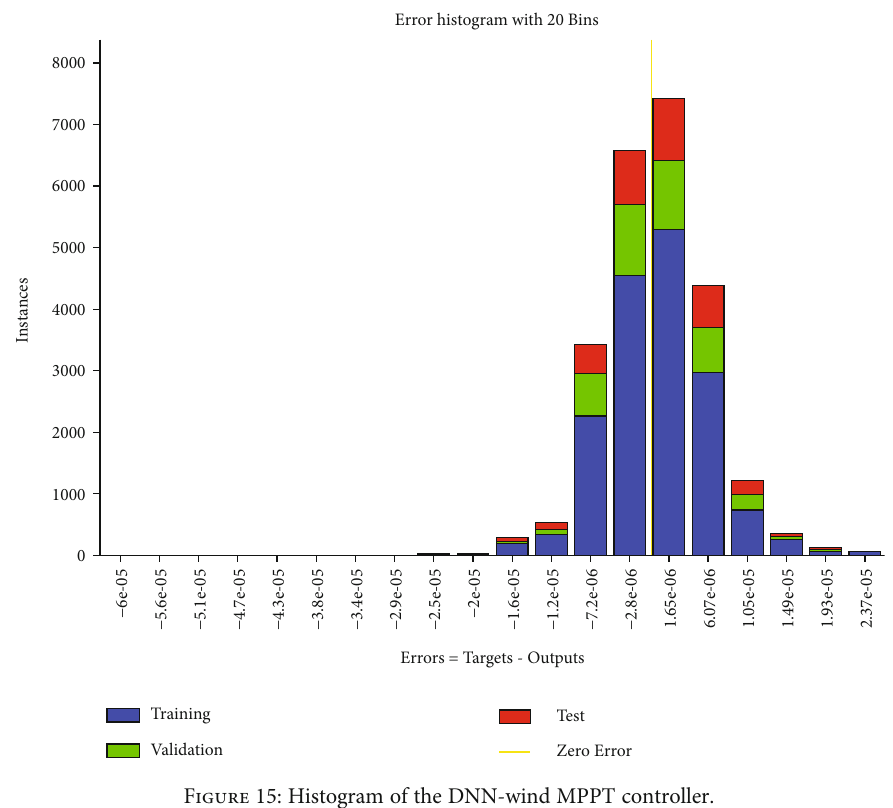
Figure 15: Histogram of the DNN-wind MPPT